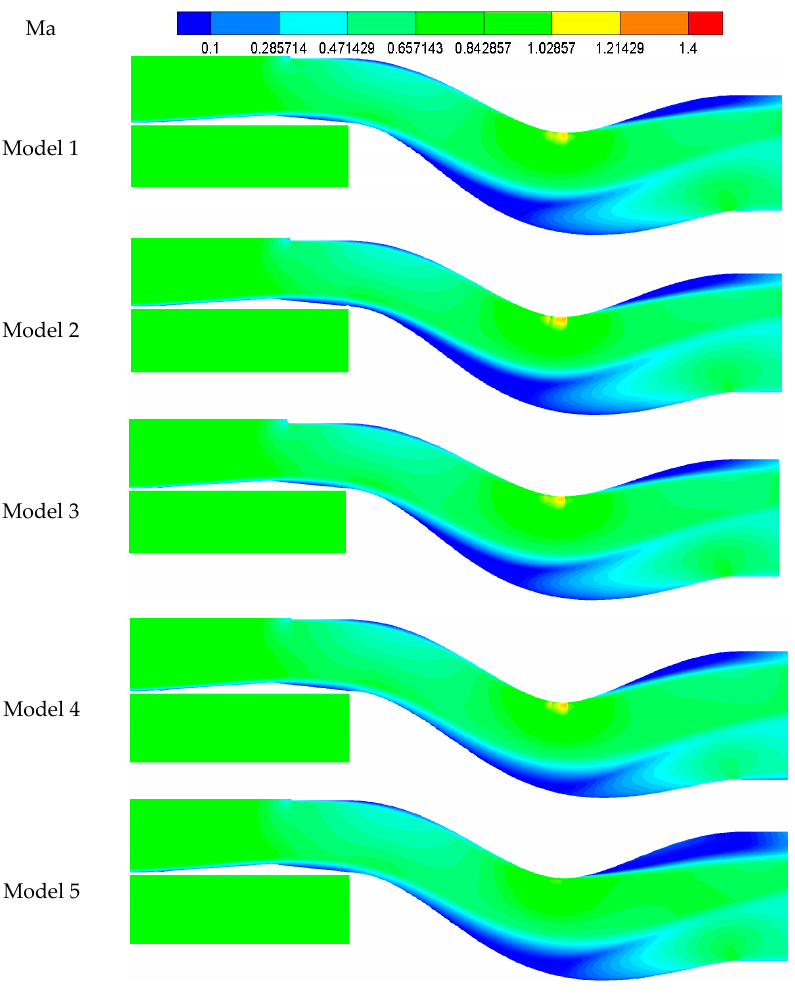
Figure 14. Mach number distribution of sample points.